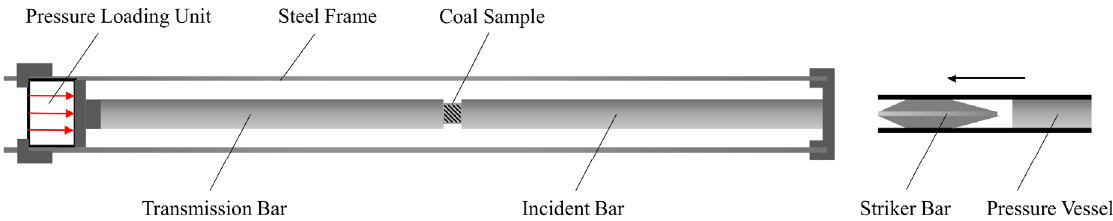
Figure 1. Schematic diagram of SHPB system for coupling loads experiment.